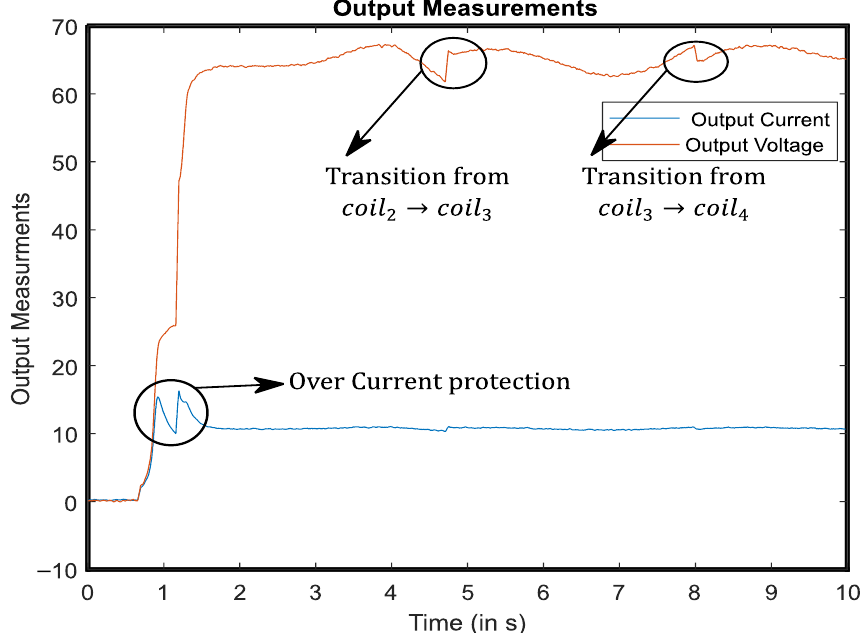
Figure 17. Voltage & Current measurements across the output of inverter n and inverter n+1 during the transient phase from coil n to coil n+1 .